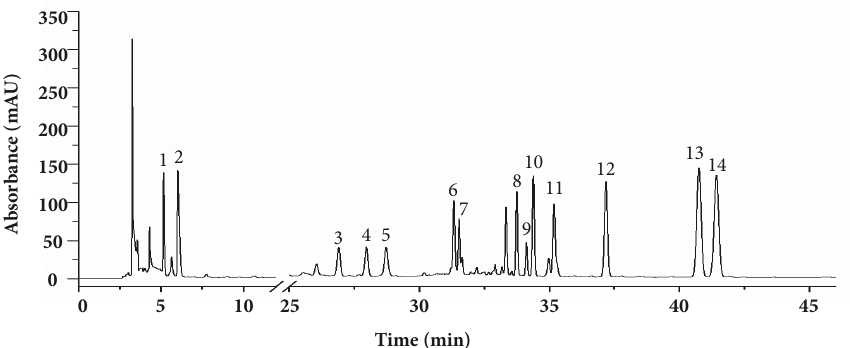
Figure 1: Separation of the alcohol-soluble extractants of LSW by using HPLC.